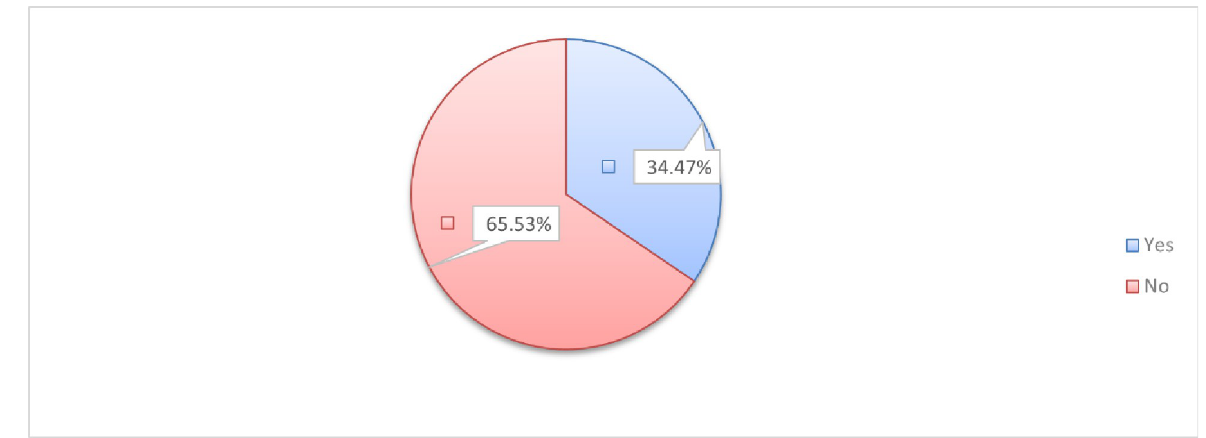
Fig 1. Magnitude of DEB among medical students at the University of Gondar, Northwest Ethiopia, 2021.